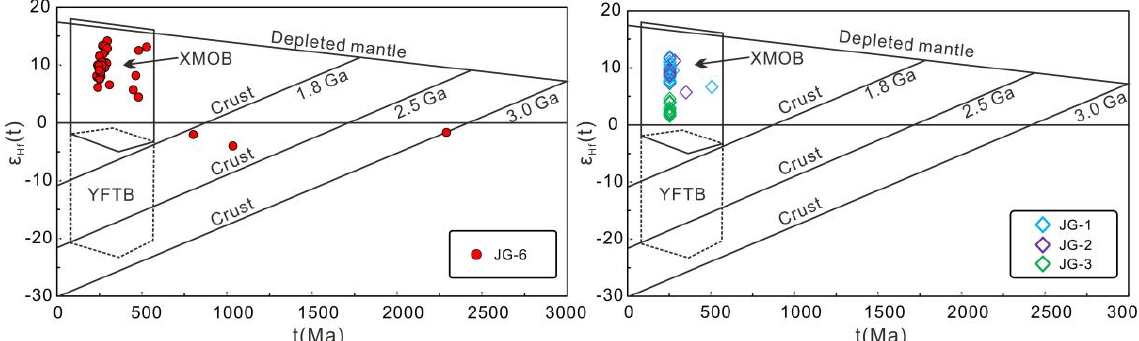
Figure 9. ε Hf (t) versus t diagram of the rocks from the Jin ′ gui Island. XMOB: Xing ′ an–Mongolia Orogenic Belt; YFTB: Yanshan Fold and Thrust Belt (Yang et al., 2006 [87]).